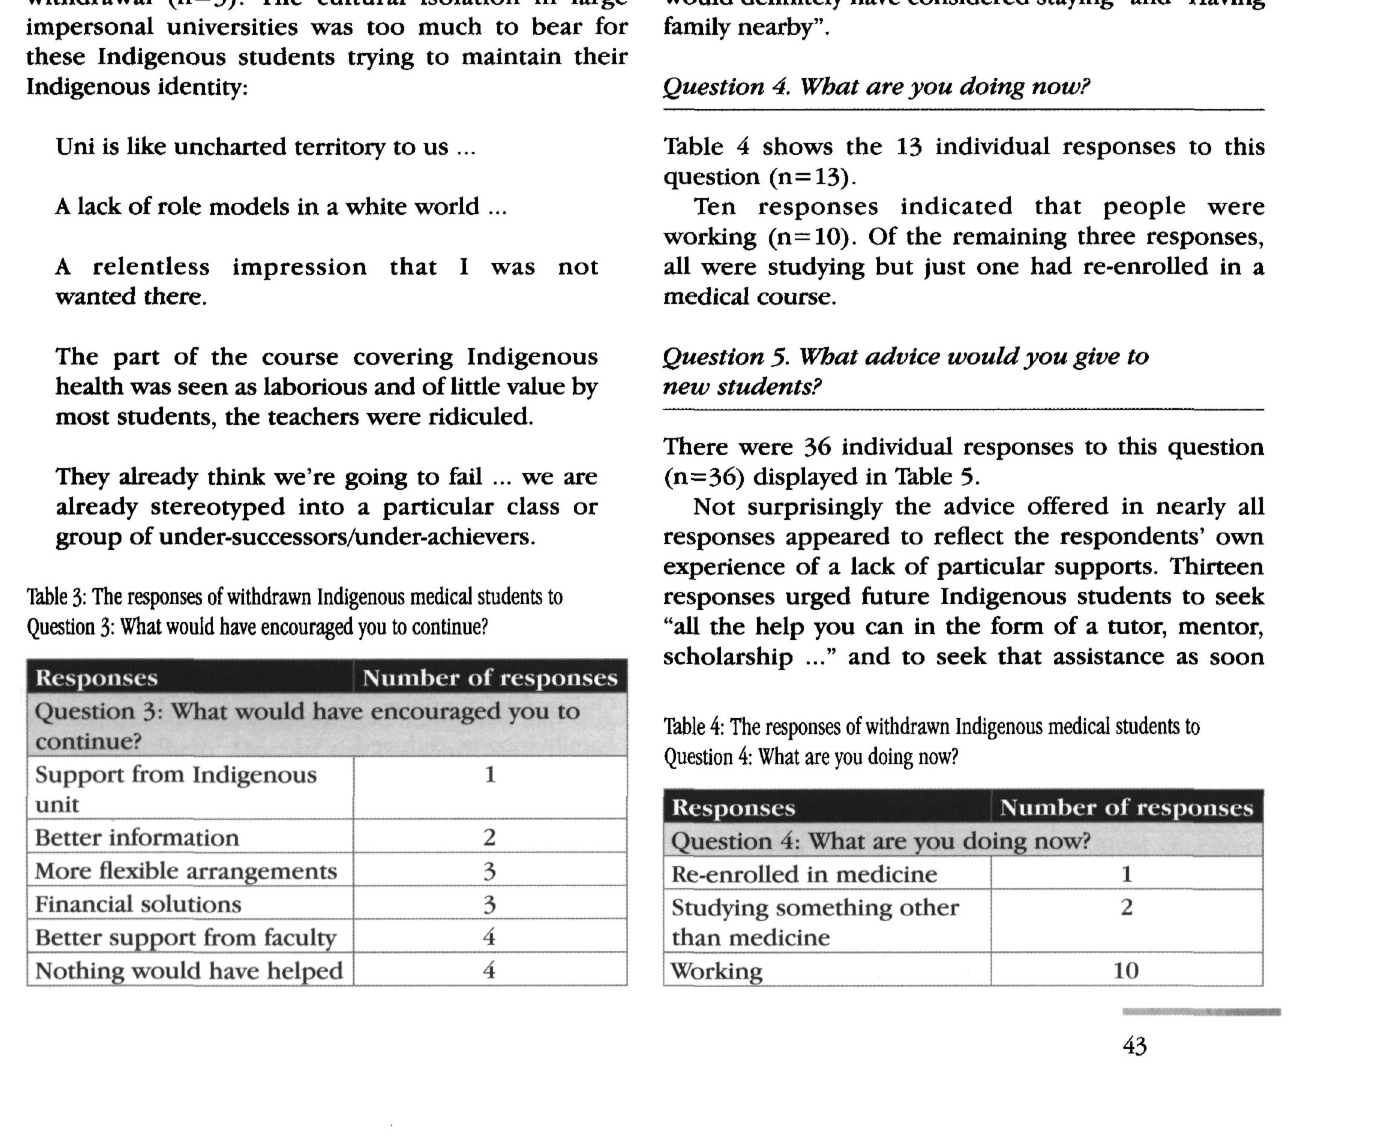
Table 4: The responses of withdrawn Indigenous medical students